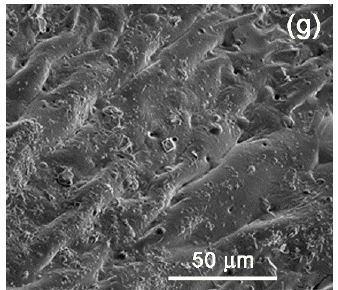
Figure 6. Comparison between FR4-containing fractured surfaces of UL 94 bars: ( a ) Neat Adeka additive, ( b ) LDPE-A/FR4 prior to UL 94, ( c ) LDPE-A/FR4 after UL 94, ( d ) LDPE-T/FR4 prior to UL 94, ( e ) LDPE-T/FR4 after UL 94, ( f ) LLDPE/FR4 prior to UL 94, ( g ) LLDPE/FR4 after UL 94.